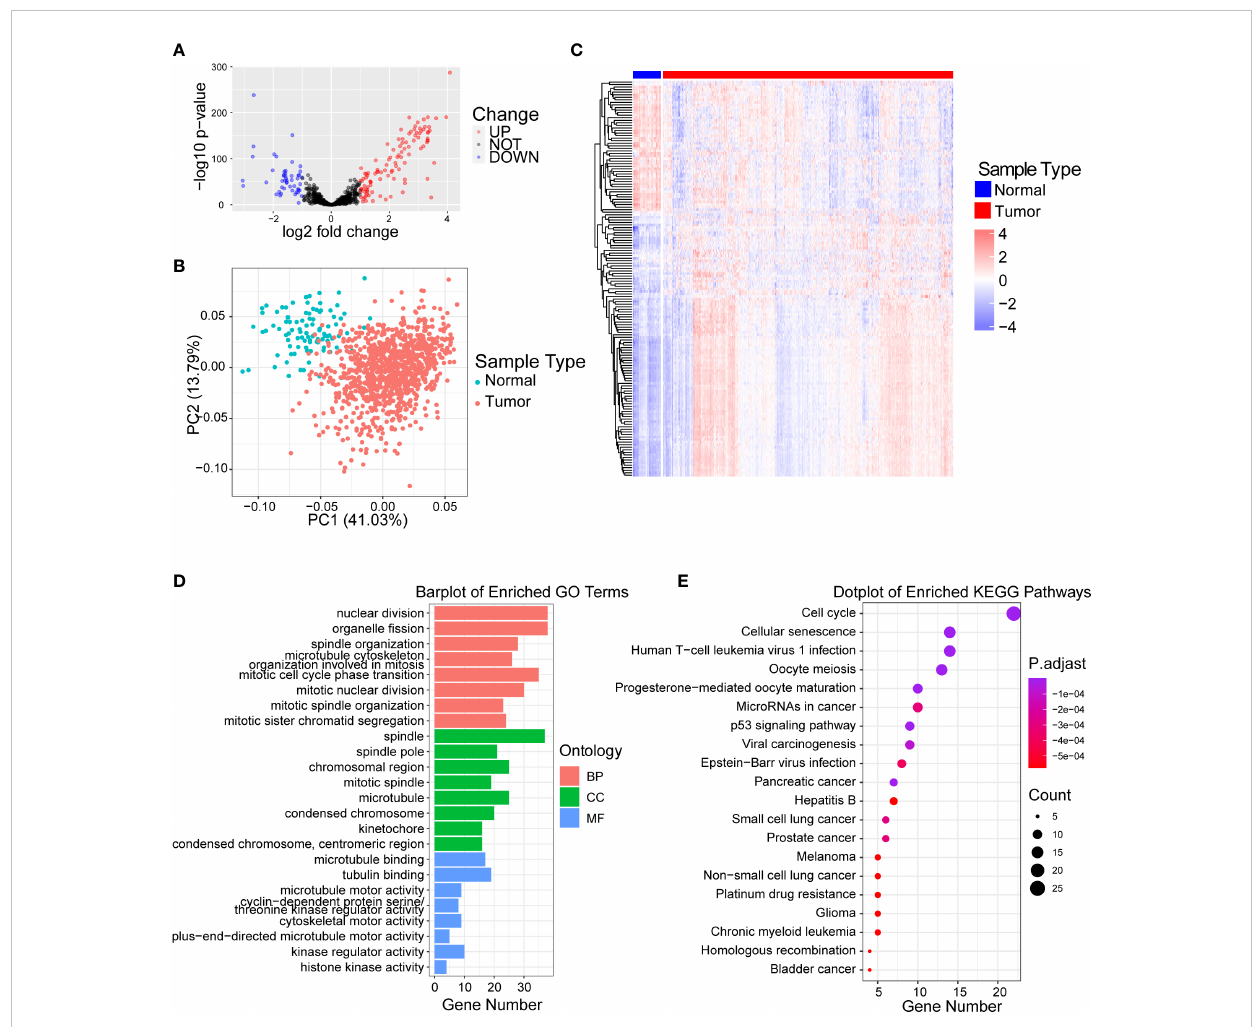
FIGURE 1 Identi fi cation of differentially expressed centrosome-related genes and functional analysis. (A) Volcano plot of the differentially expressed centrosome-related DEGs by comparing breast cancer tissues to normal prostate tissues from TCGA-BRCA cohort. Blue represents downregulated genes, and red represents upregulated genes in BRCA. p< 0.05, |log2 fold change| > 1.0. (B) Principal component analysis (PCA) of TCGA-BRCA cohort for optimal k = 2. (C) Heatmaps of centrosome-related DEGs. (D) GO enrichment of upregulated centrosome-related DEGs. (E) KEGG pathways of upregulated centrosome-related